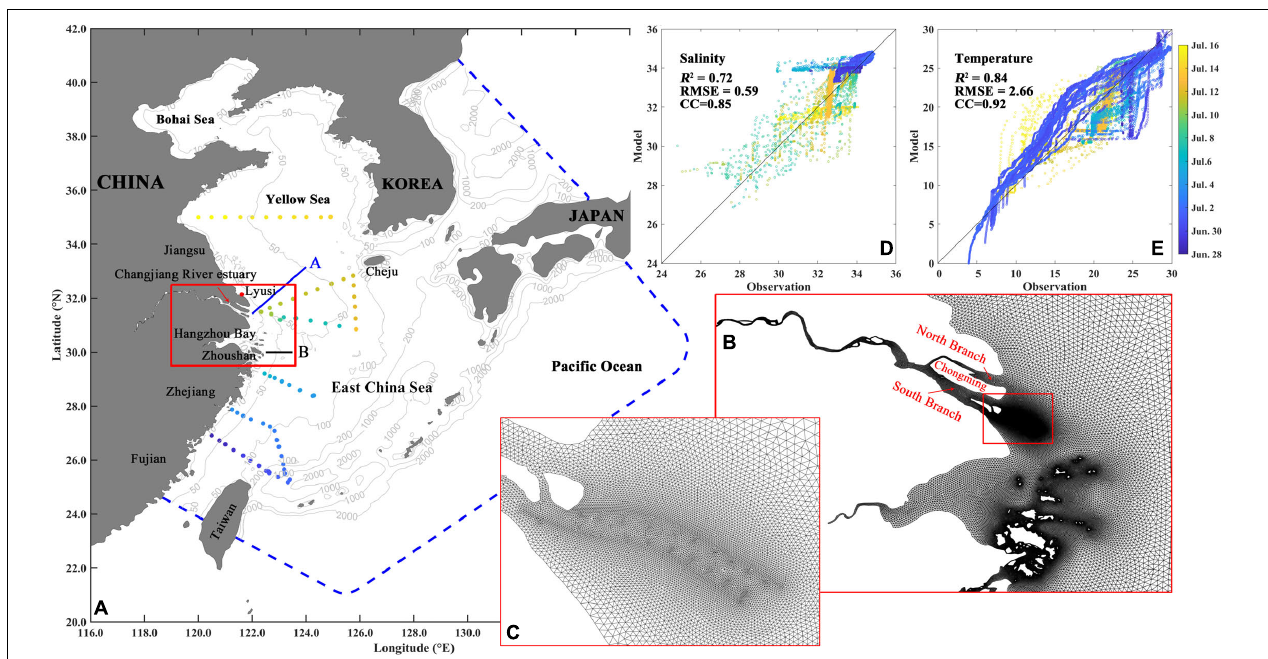
FIGURE 1 | (A) The model coverage with the observation stations during the first cruise from June 28 to July 16, 2006, two cross-sections A/B in blue/black solid lines, and zoom-in mesh-grids in (B) the Changjiang River estuary [red box in panel (A) ] and (C) the Deep Navigation Channel [red box in panel (B) ]. The comparison between the observed and modeled (D) salinity and (E) temperature during the first cruise. Color in panels (A,D,E) indicate the date of